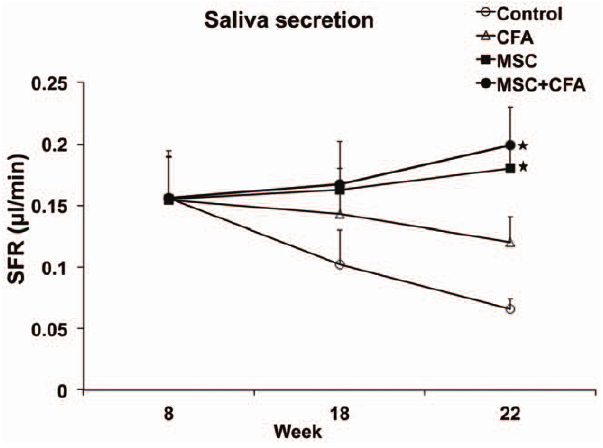
Figure 1. Salivary flow rates (SFRs) of NOD mice. SFRs in MSC + CFA (black circle; n=10) and MSC (black square; n=5) groups did not decrease during the follow-up period (22 wk of age) and were significantly higher than SFRs of CFA-treated or control NOD groups (n=5 per group; P , 0.05). SFRs in CFA (triangular) or control (untreated; open circle) groups continued to decrease during the follow-up period (* P , 0.05).